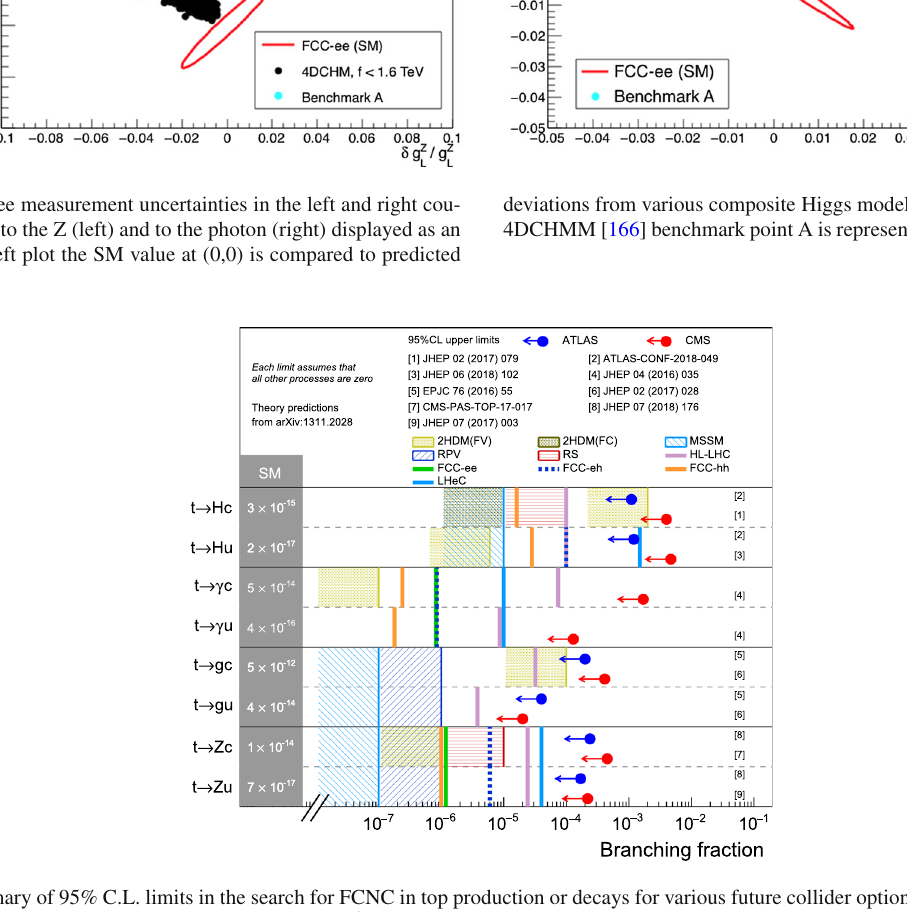
Fig. 6.4 Summary of 95% C.L. limits in the search for FCNC in top production or decays for various future collider options, compared to current LHC limits. The study of the top FCNC decays reach at e + e − linear colliders was recently presented in Ref.